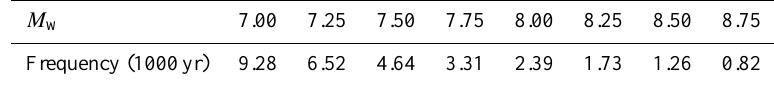
Table 5. Frequency of events (in 1000yr) for a magnitude equal to or exceeding the tabulated